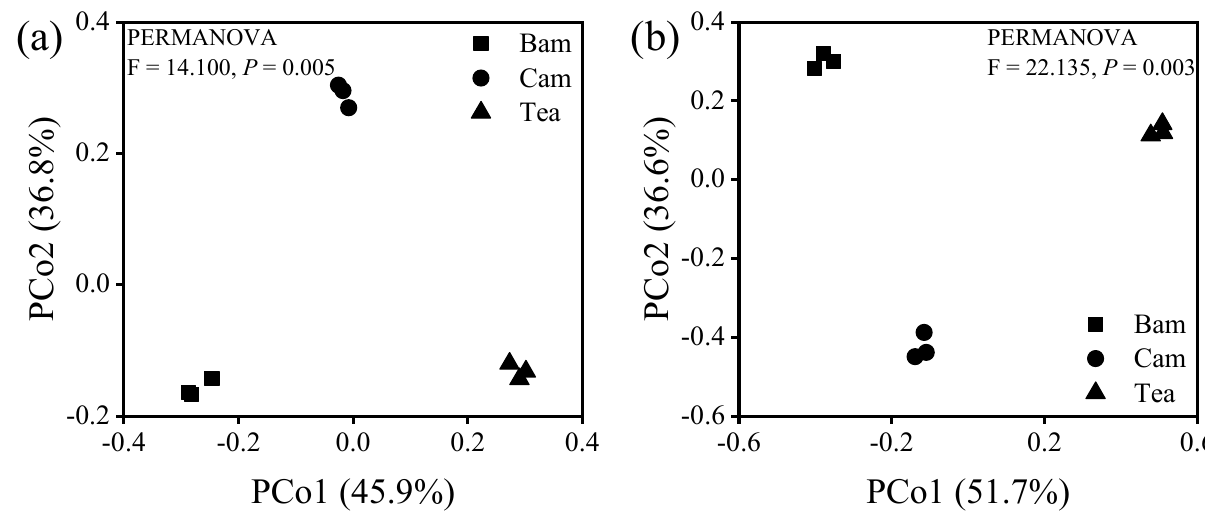
Figure 3. Principal co-ordinates analysis (PCoA) ordination plots of soil bacterial ( a ) and fungal ( b ) communities from bamboo (Bam), camphor (Cam), and tea (Tea) plantations.